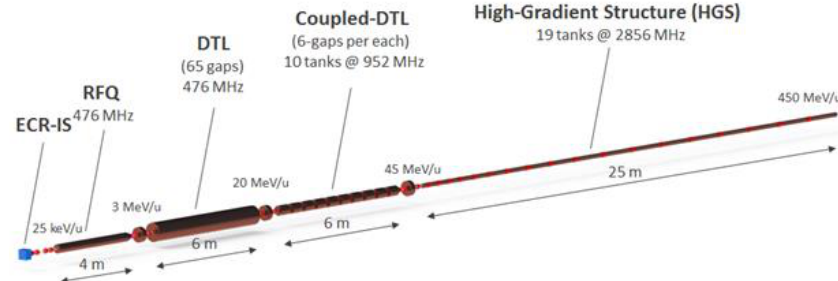
Figure 3. Layout of the proposed ACCIL design.